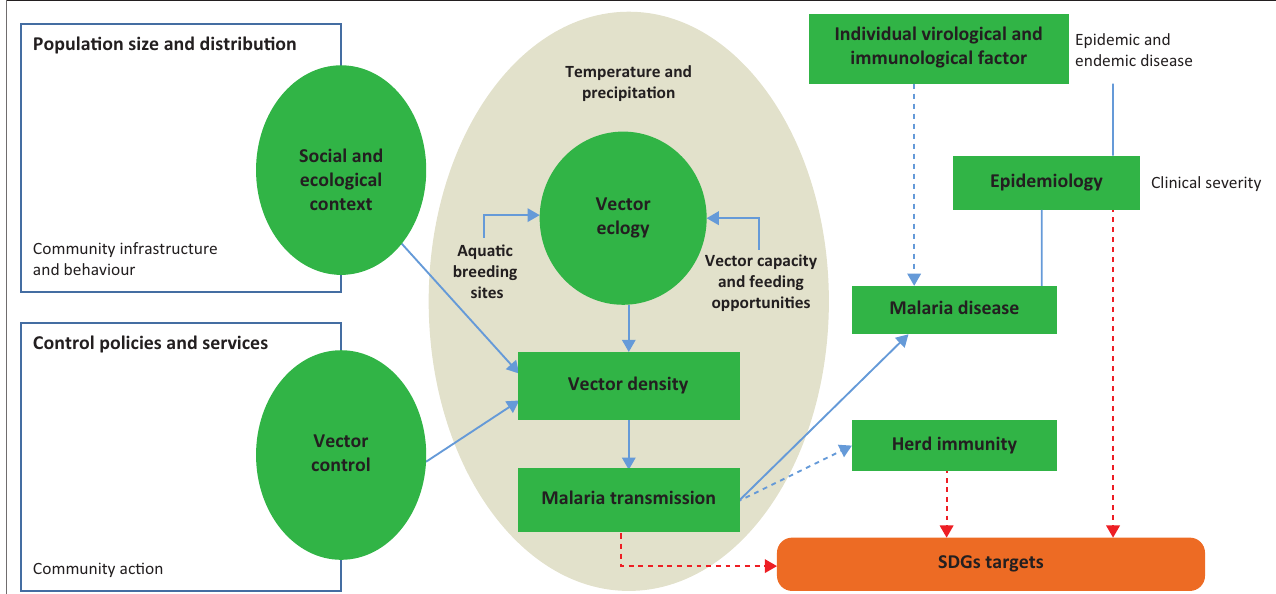
FIGURE 1: The climate–malaria interface and its link to sustainable development